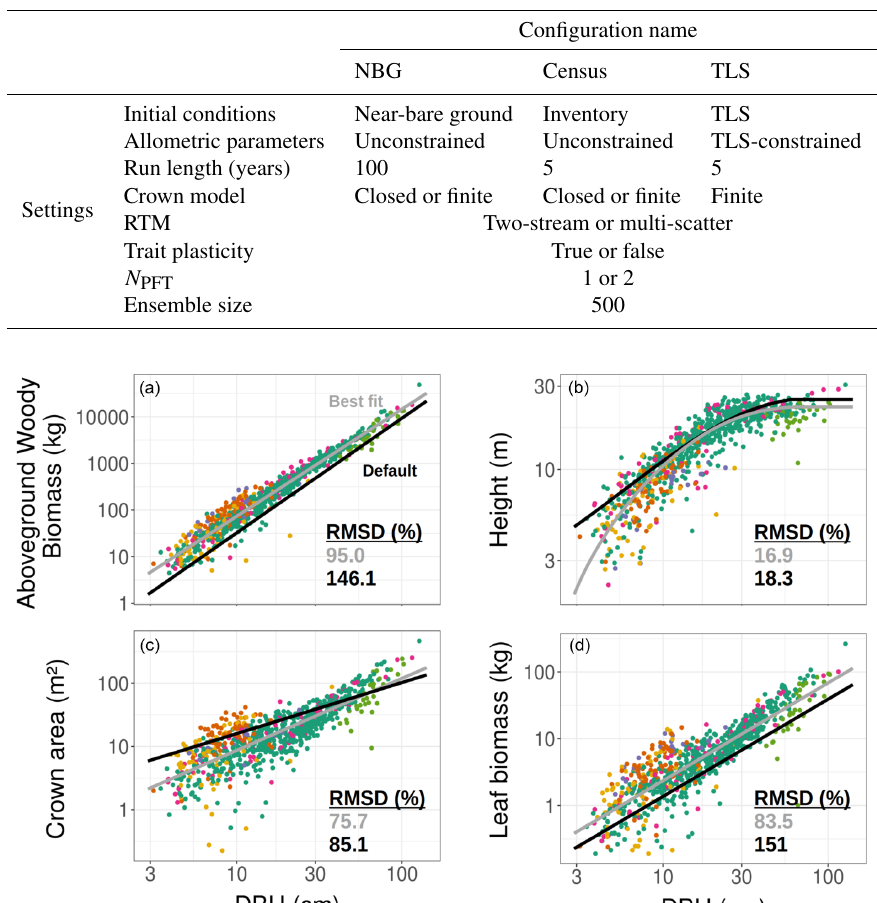
Table 5. Summary of the model configurations used in this study and the underlying model settings.